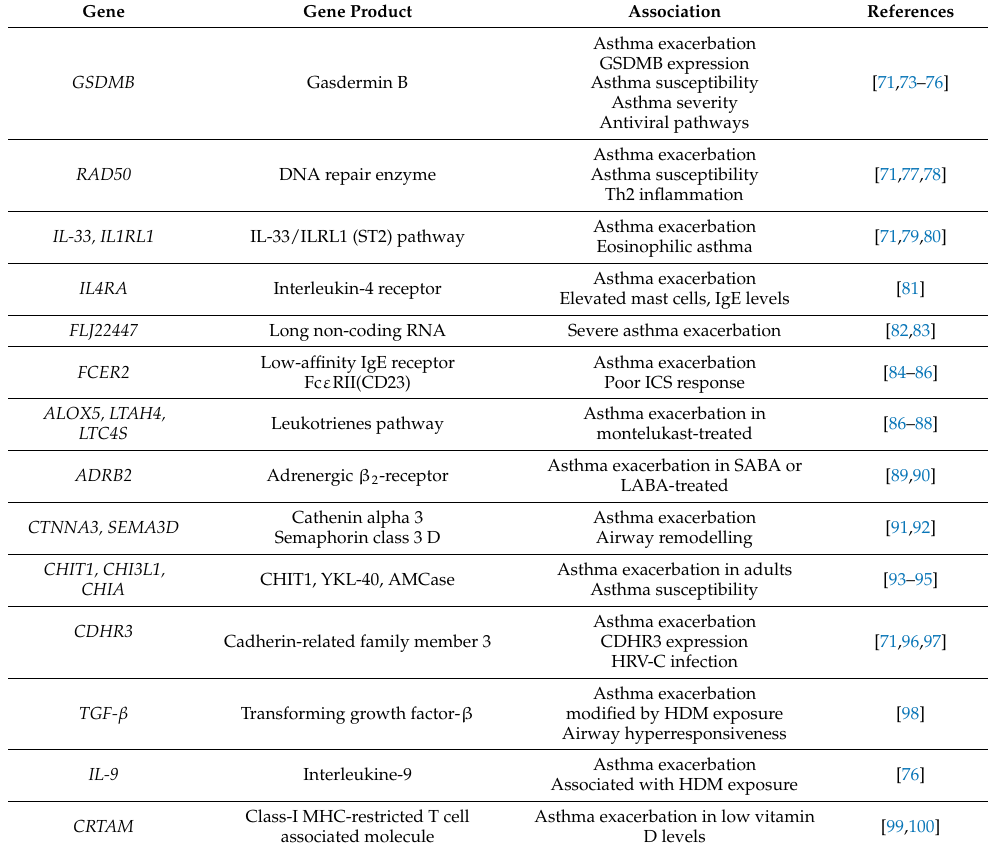
Table 2. Summary of genetic variants associated with asthma